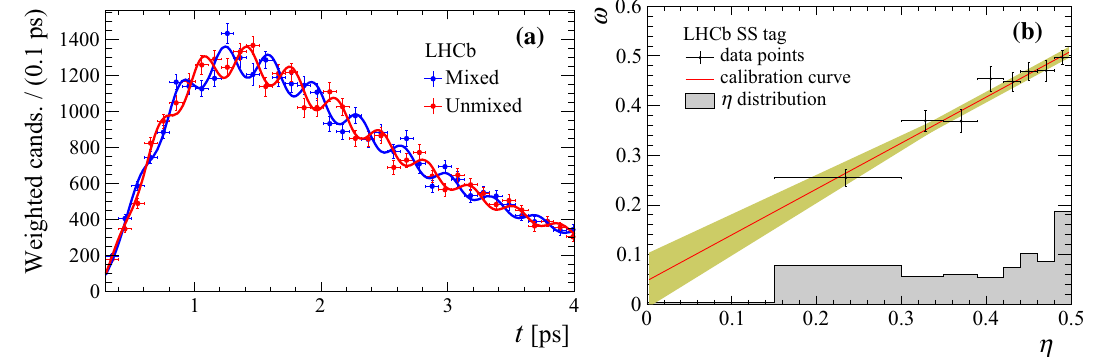
[ps] t the calibration obtained from the fit described in the text, and the yel- low area the calibration uncertainty within one standard deviation. The shaded histogram shows the distribution of η in the background sub- tracted B 0 s → J /ψ φ